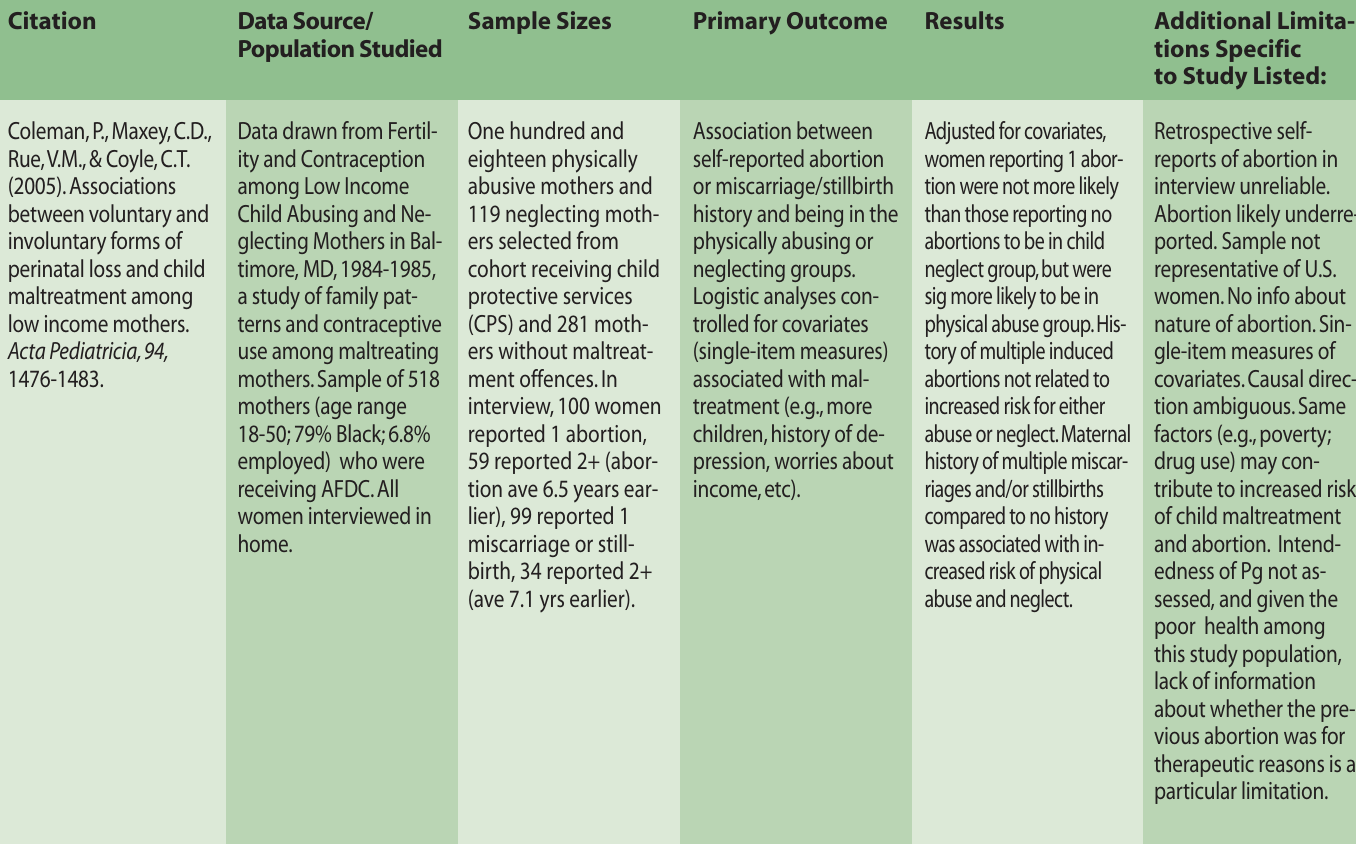
Table 2: Secondary Analyses of Survey Data–Abortion vs.Comparison